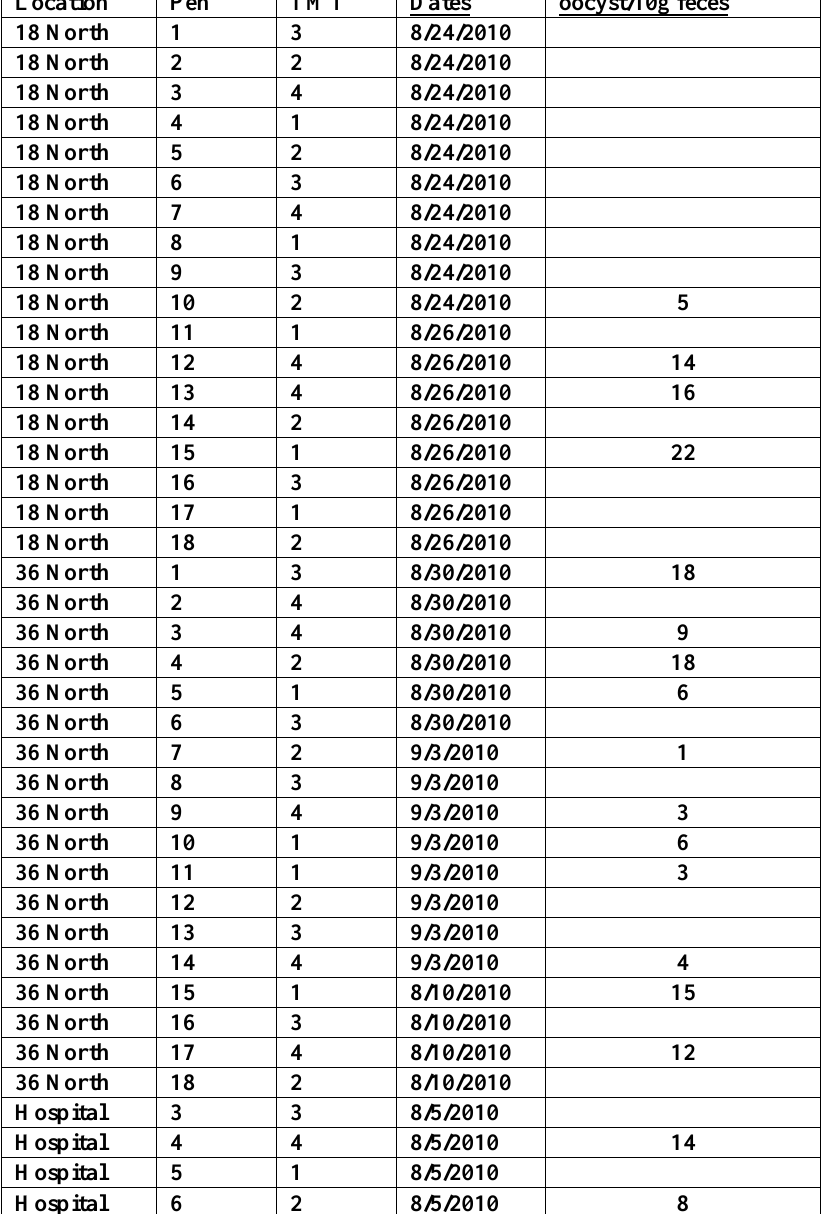
Table (2) Pen numbers Calves treated groups and oocysts numbers/10g of